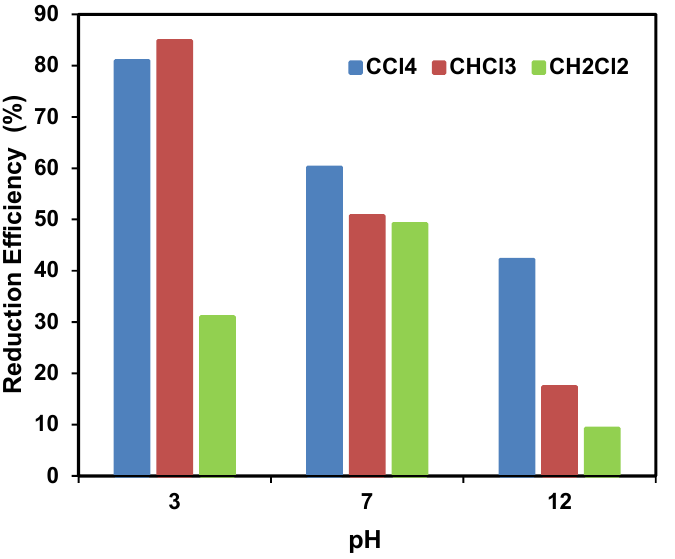
Figure 4. pH Variation on the dechlorination efficiency of the organochlorides (experimental condi- tions: 5 mM concentration of CCl 4 , CHCl 3 , and CH 2 Cl 2 , electrolysis time: 30 min, current density: 15 mA/cm 2 ).